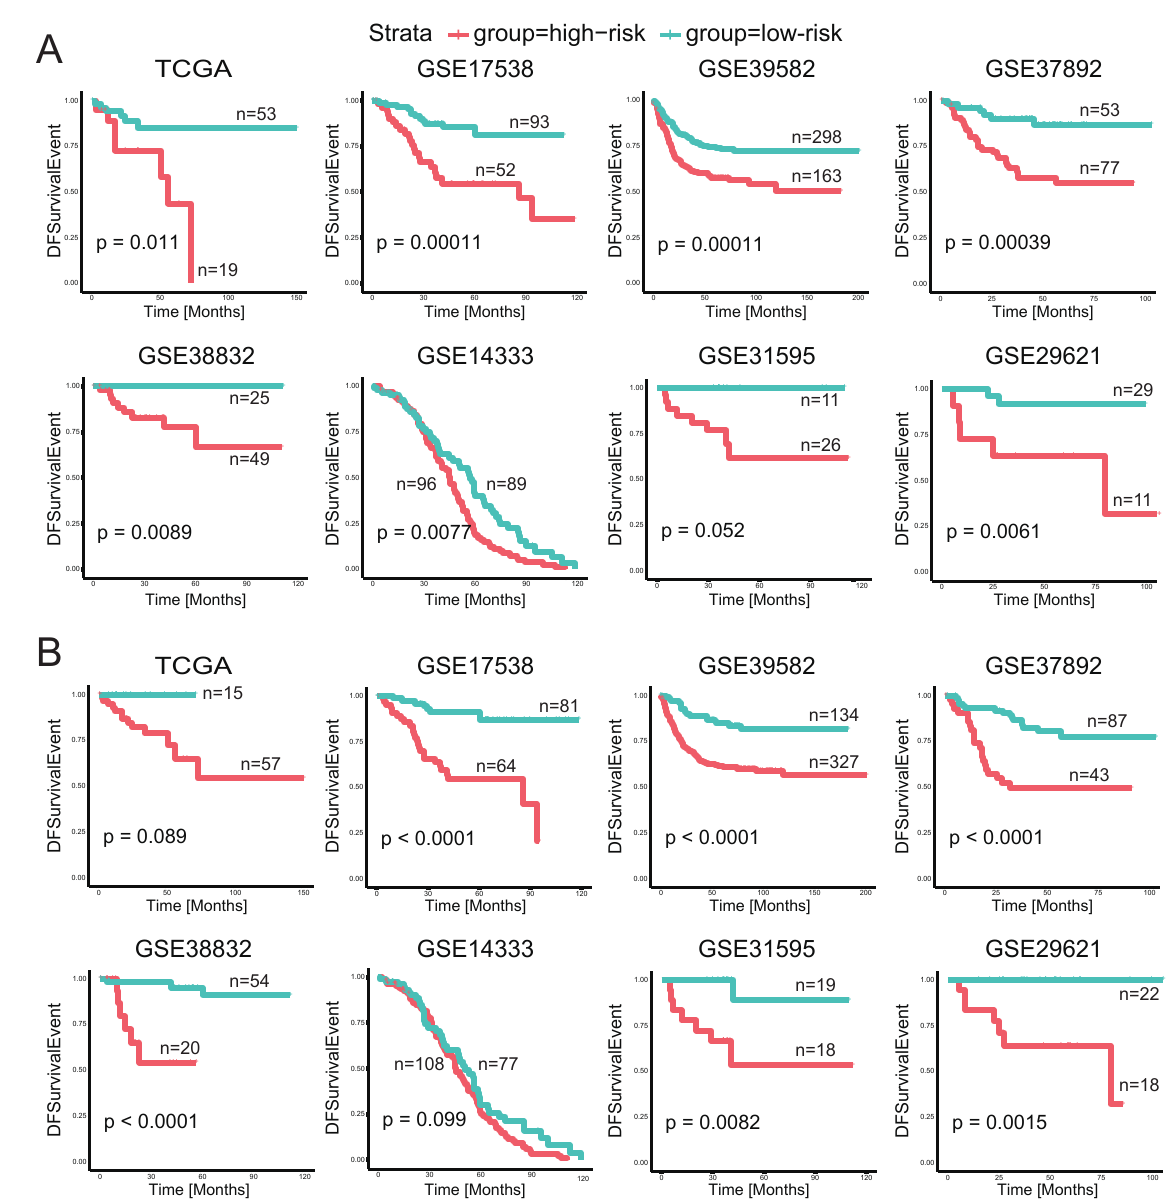
Figure 3. Kaplan–Meier survival curves of DFS between high-risk and low-risk groups in CRC validation datasets: ( A ) CUPsig, ( B )